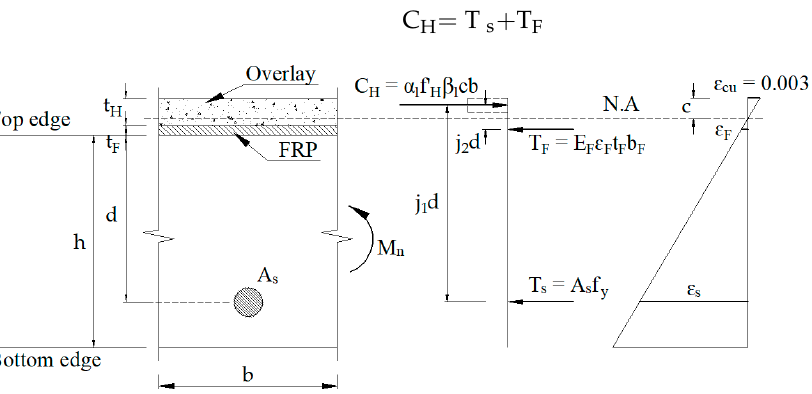
Figure 2. Calculating mechanism for slab’s positive moment sections with a proposed